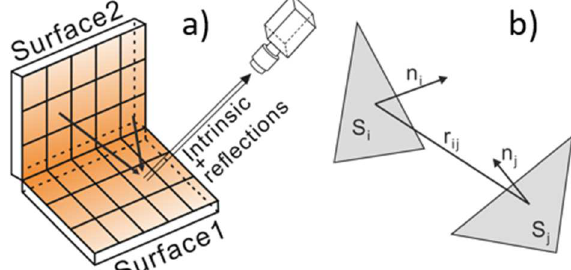
Fig. 1. Illustration of self-illumination for two surfaces (a) and spatial configuration of surface elements